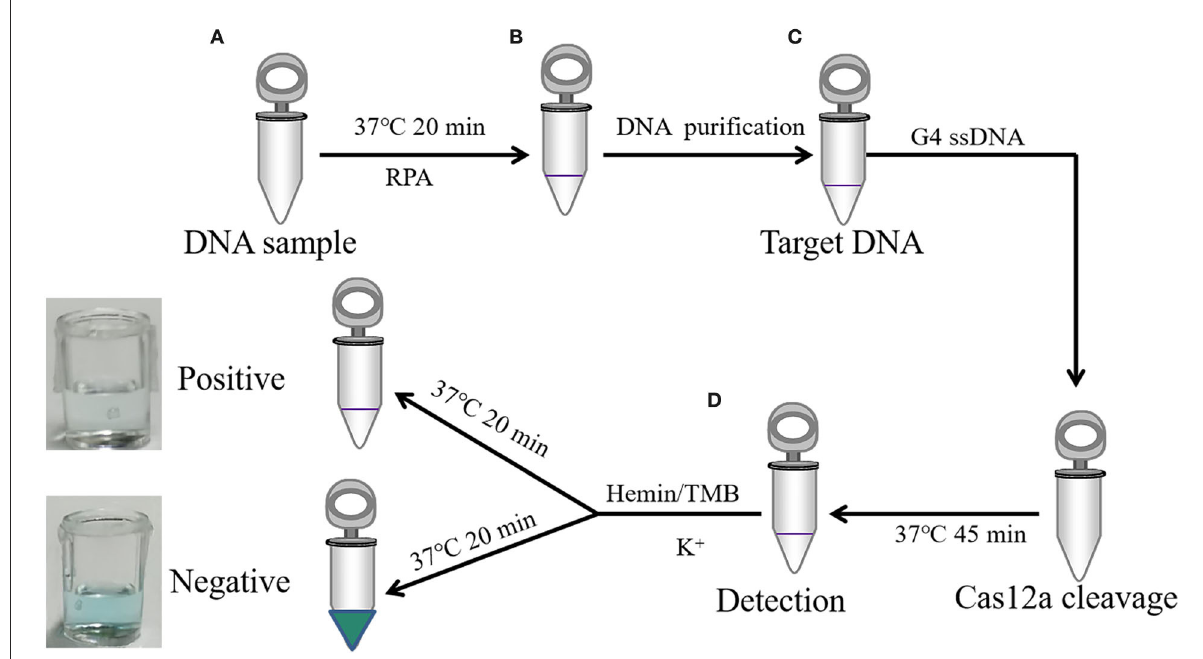
FIGURE3 A schematic illustration of DNA detection by CRISPR-Cas12a combined with G-quadruplex. (A) RPA amplified target sequence. (B) Target DNA magnetic bead purification. (C) LbCas12a cleavage target DNA and non-specific cleavage G-quadruplex ssDNA incubated at 37 ◦ C for 60min. (D) Color observation after incubation adding hemin, TMB, and K + at 37 ◦ C for